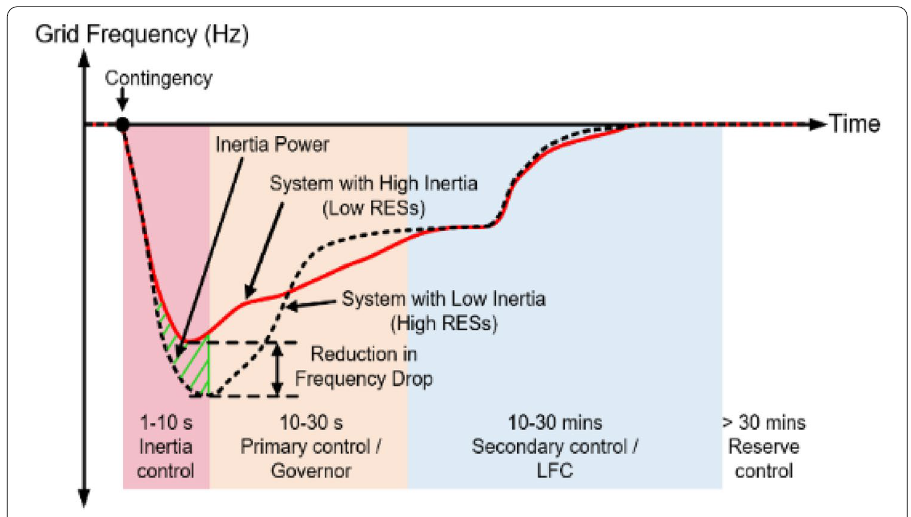
Fig. 1 Time-scale of frequency response during power system contingency